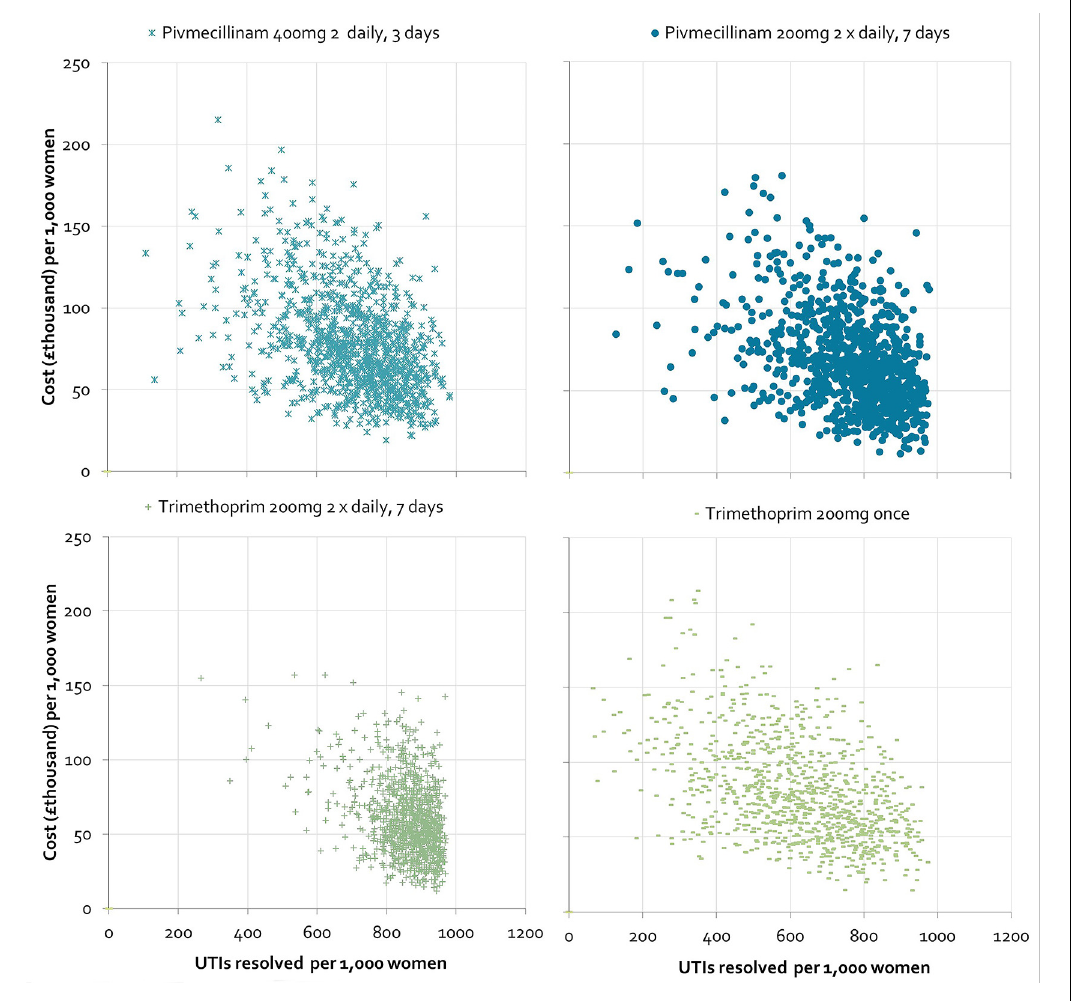
Figure 3. Cost-effectiveness plane comparing all treatment